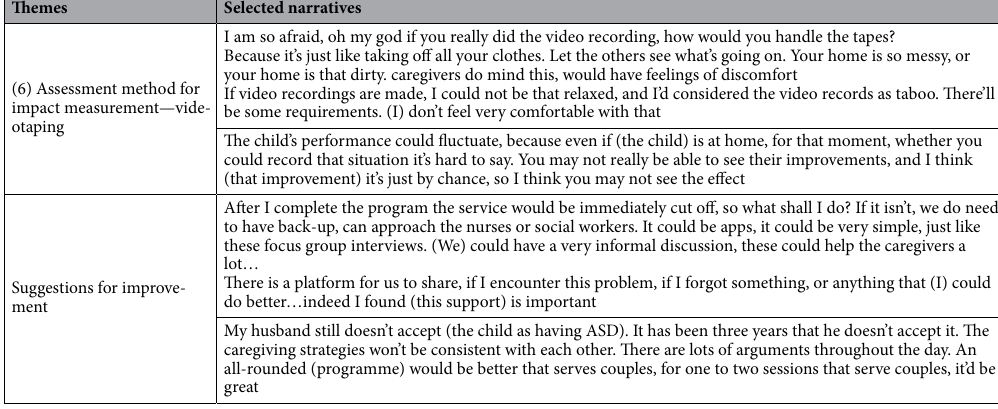
Table 4. Themes and selected narratives of the needs assessment focus group with caregivers (n = 15) in phase 1.